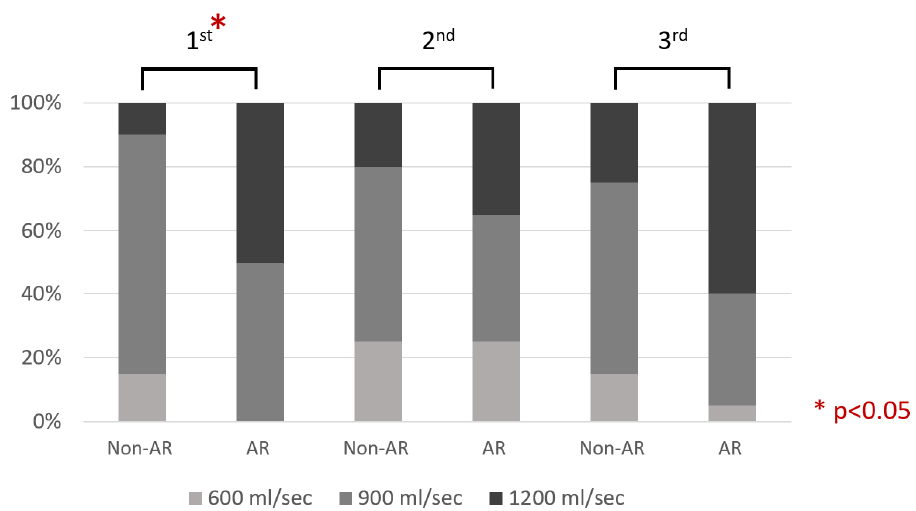
6 of 11 Figure 2. Distribution of the demographic characteristics in the study population: ( a ) gender, ( b ) age, and ( c ) years of education. 3.2. Objective Outcome The incentive spirometry ranked the patients’ inspiratory flow rate as 600, 900, or